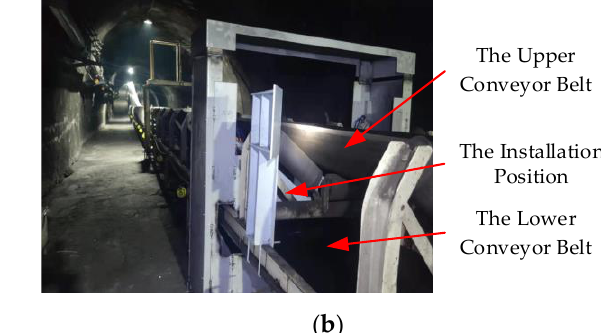
Figure 2. Installation position of upper belt image acquisition device on the conveyor. ( a ) Picture of the device installed in the laboratory. ( b ) Picture of device installed on site.